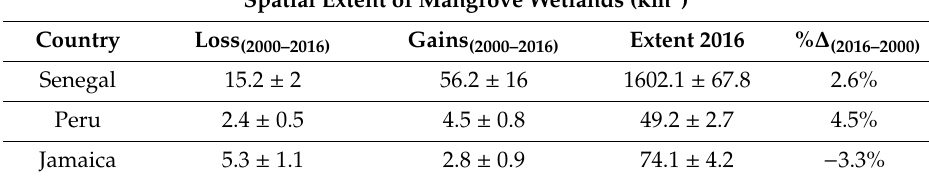
Table 3. Mangrove land cover change from 2000 to 2016 for the countries of Senegal, Peru, and Jamaica extracted using Landsat, Sentinel, and SRTM data. Area values are corrected based on reference data with the reported area uncertainties at a 95% confidence